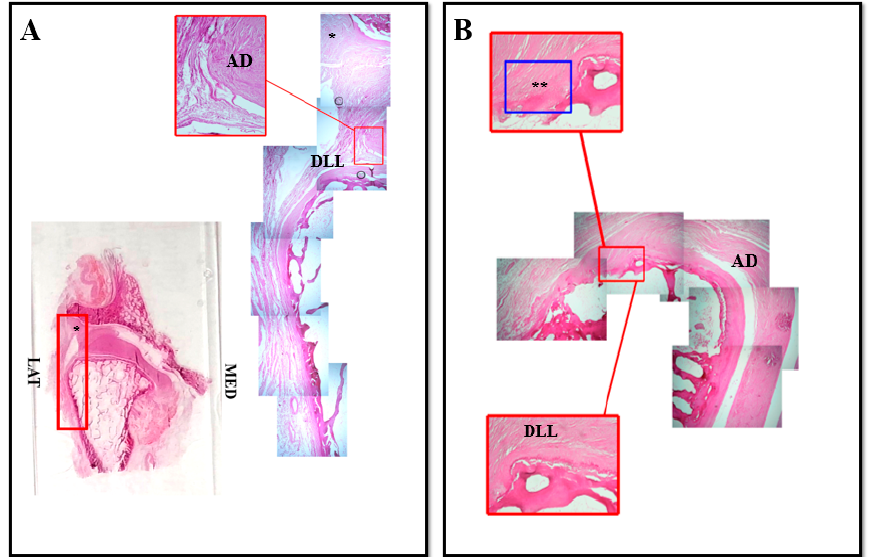
Figure 1. Compound panel of Hematoxylin-Eosin staining of human TMJ, lateral side (red box). Sections were reconstructed in order to observe a wide microscopic field at the level of the lateral side of TMJ. It is possible to observe the existence of an anatomical structure that made up of nondissociable fibers that seems to give life to two connective bundles: the first one originates from the lateral region of the disc and, running upwards, it inserts on the capsule (( A ), asterisk); the second one originates from the lateral region of the disc and it runs downwards inserting on the superficial layer of the articular cartilage of the condyle (( A ), DLL). In our opinion this second structure corresponds to the discal lateral ligament; in ( B ) pictures show the direct insertion of discal lateral ligament on the superficial layer of mandibular condyle cartilage surface (double asterisk). AD: articular disc; DLL: discal lateral ligament; LAT: lateral; MED: medial.